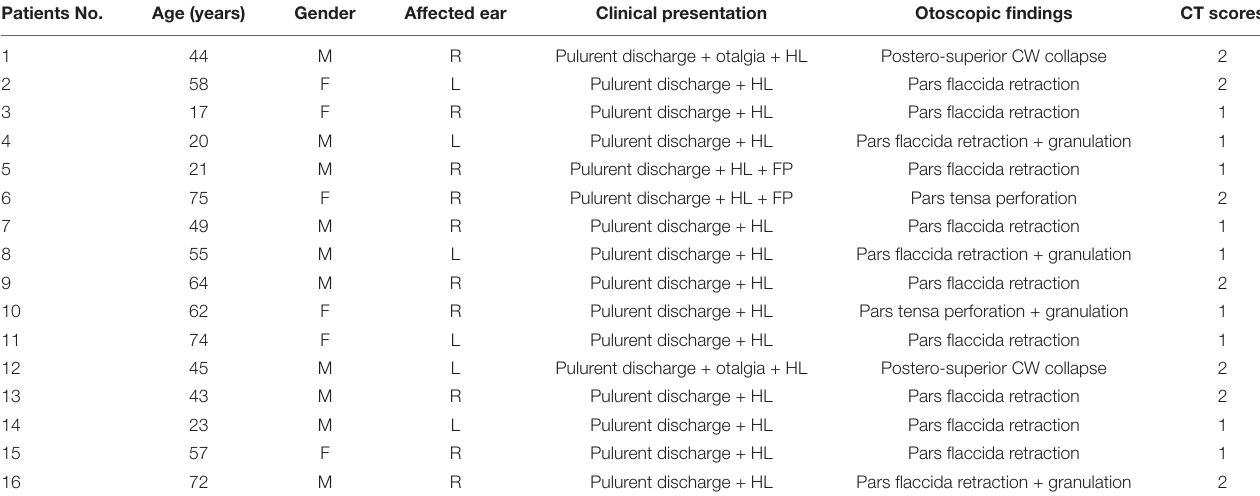
TABLE 2 | The demographic data and clinical features of patients with cholesteatoma. Patients No.